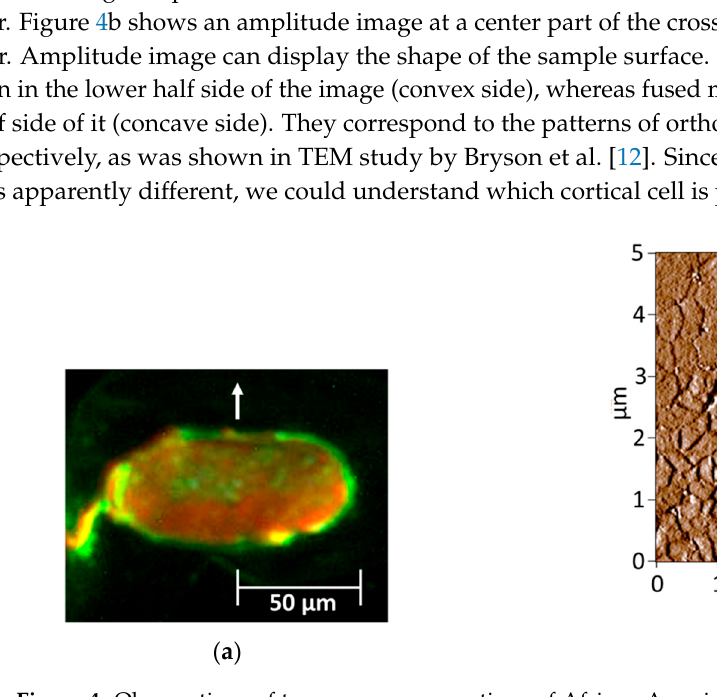
Figure 4. Observations of transverse cross sections of African-American hairs. ( a ) An example of a fluorescence light microscope image of a section stained with two fluorescent dyes; ( b ) an amplitude image (5 × 5 μ m) from an atomic force microscope (AFM) at the center part of a hair. In both pictures, the arrows indicate the curvature directions from the convex to the concave side.